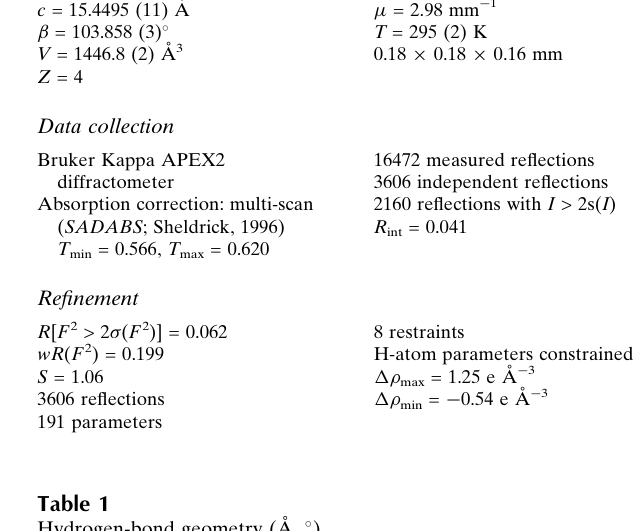
Hydrogen-bond geometry (A˚ , (cid:1)